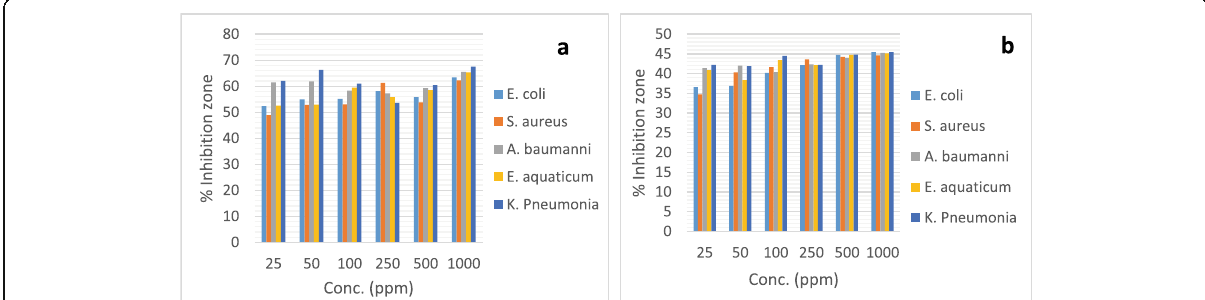
Fig. 5 Comparative antibacterial evaluation of A. occidentale leaf extract-mediated biosynthesized ZnO nanoaggregates from a ZnAc and b ZnCl 2 precursors for selected